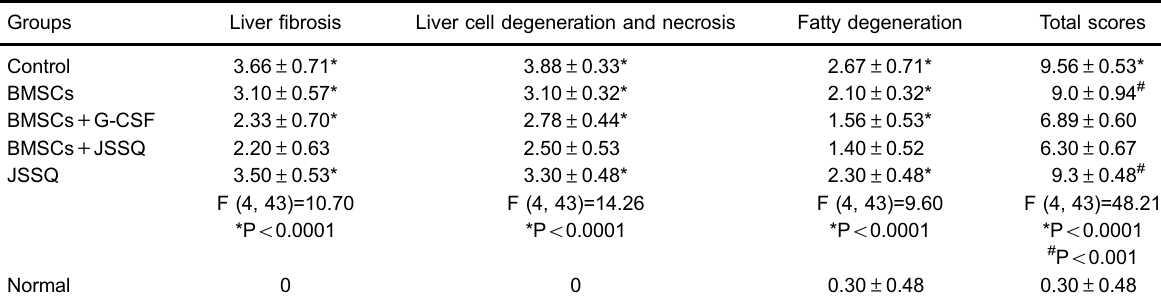
Table 1. Histopathological scores after treatment in cirrhotic rats.